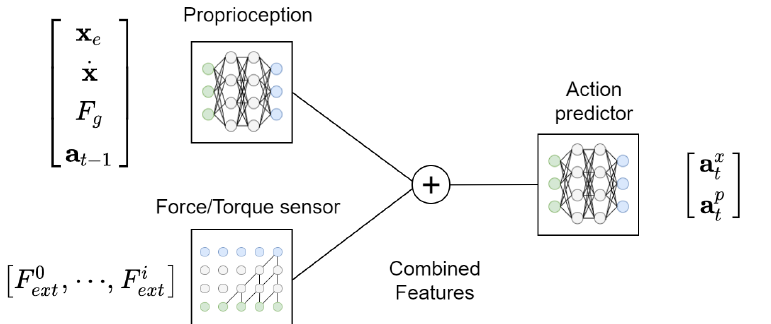
Figure 3. Control policy consisting of three networks. First, proprioception information is processed through a 2-layer neural network. Second, force/torque information is processed with a temporal convolutional network. Lastly, extracted features from the first two networks are concatenated and processed on a 2-layer neural network to predict